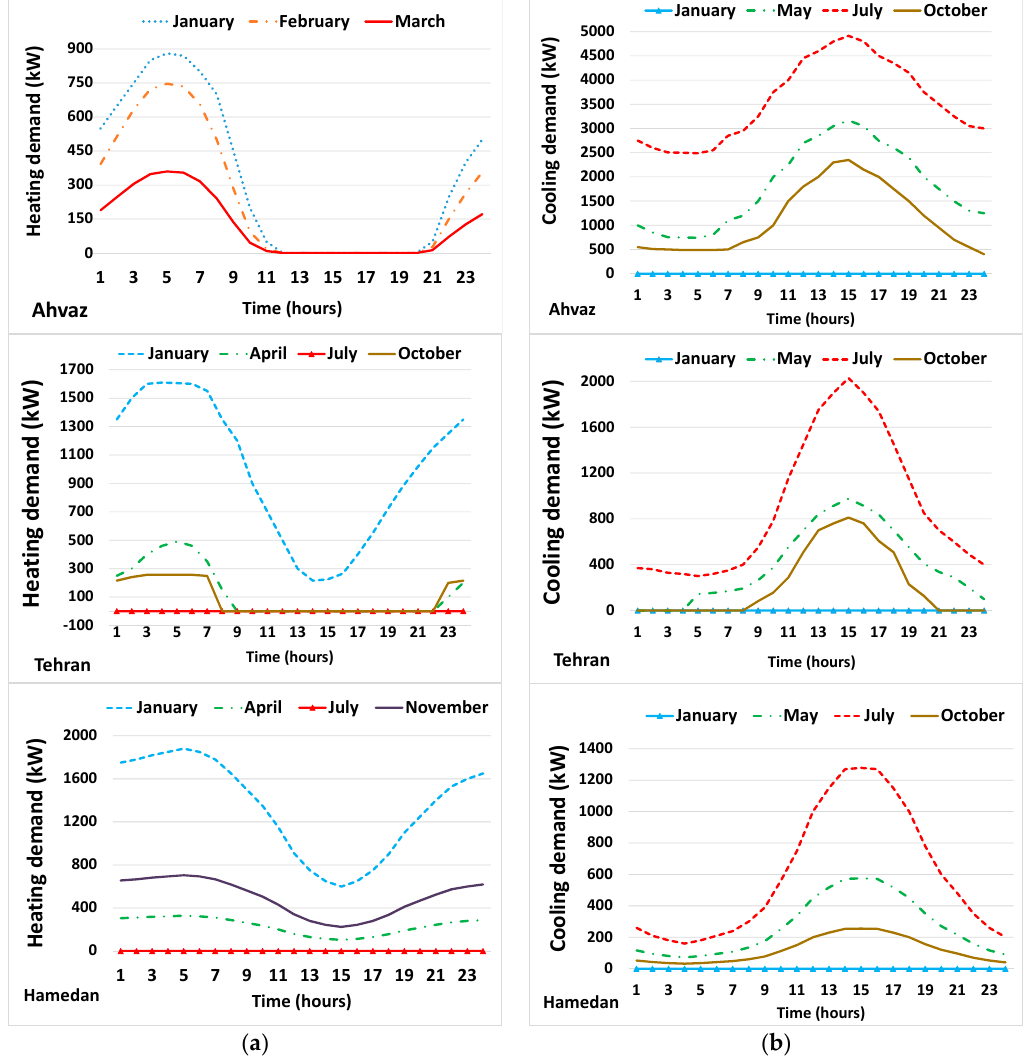
Figure 6. Heating ( a ) and cooling ( b ) demand of the building in Ahvaz, Tehran, and Hamedan [36].